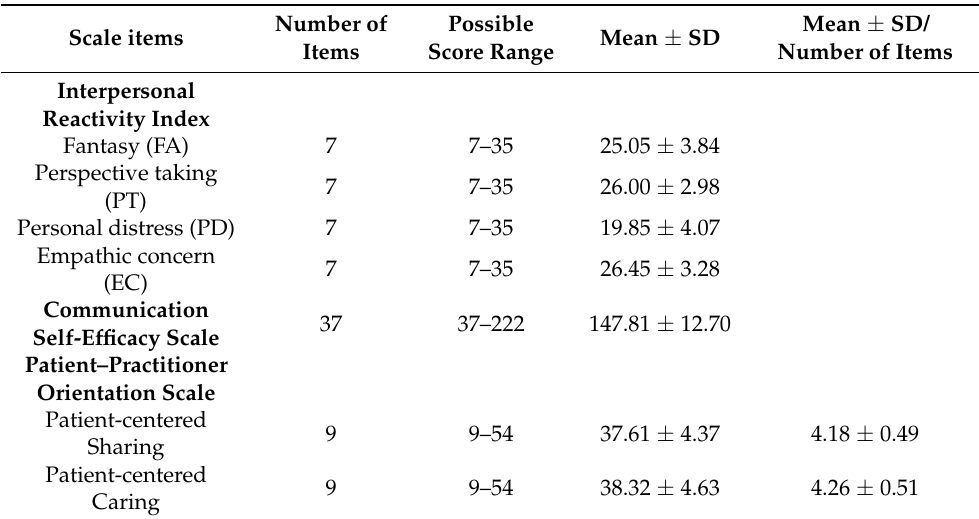
Table 2. Scores on Interpersonal Reactivity Index, Communication Self-Efficacy, Patient–Practitioner Orientation Scale ( n = 201).